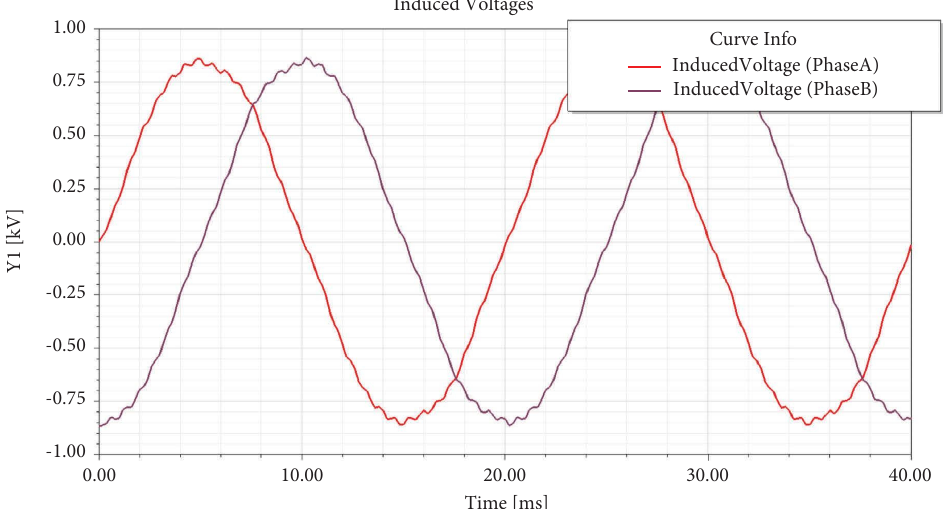
Figure 19: Back EMF curves of 4-pole 30-slot